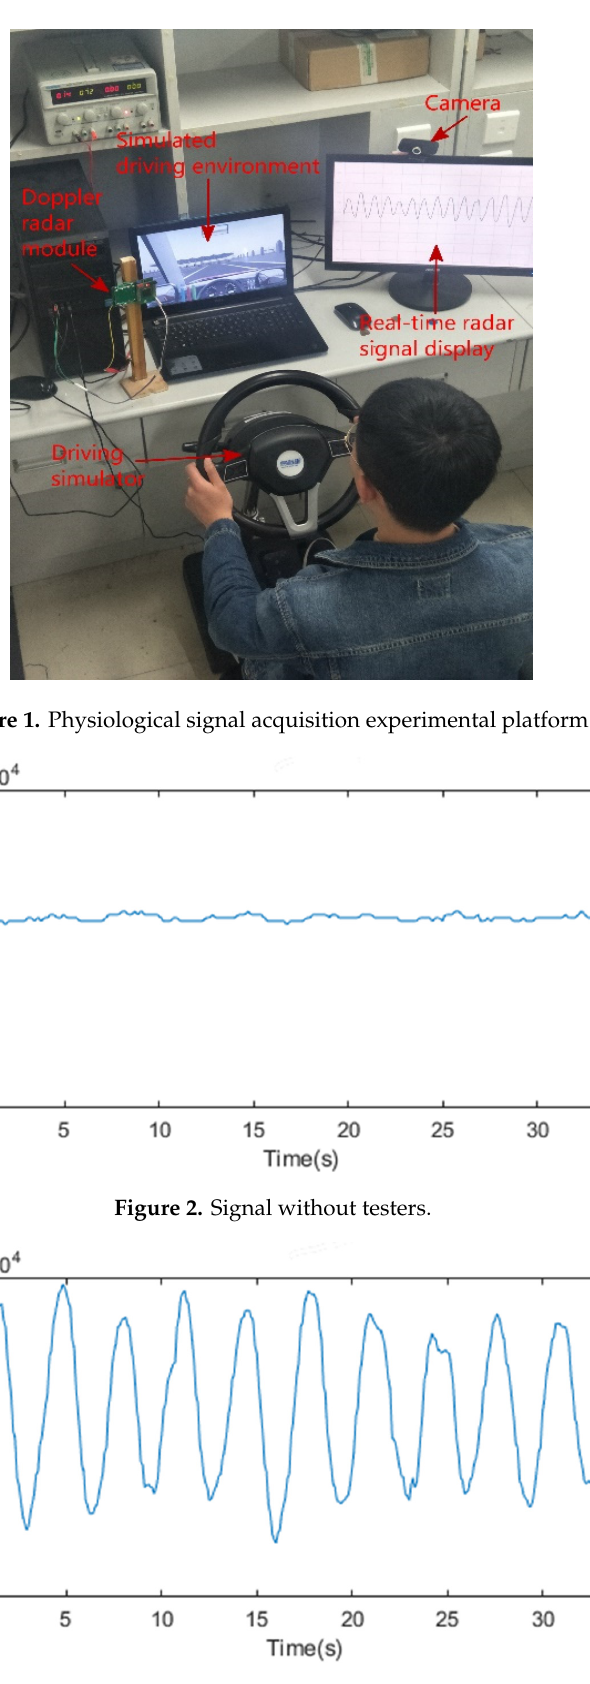
Figure 3. Tester’s signal when breathing normally.